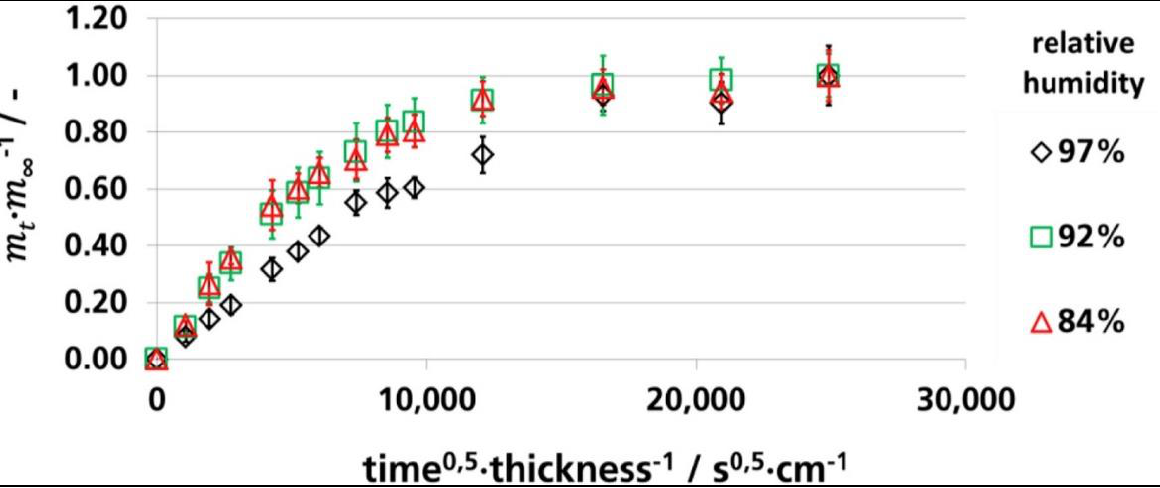
Figure 10. Water vapor absorption at 23 °C; PP with 6 wt. % NaCl, foamed and stretched with stretching factors of 2.5 × 2.5. Reproduced from ref. [108] with permission from Elsevier. 2018